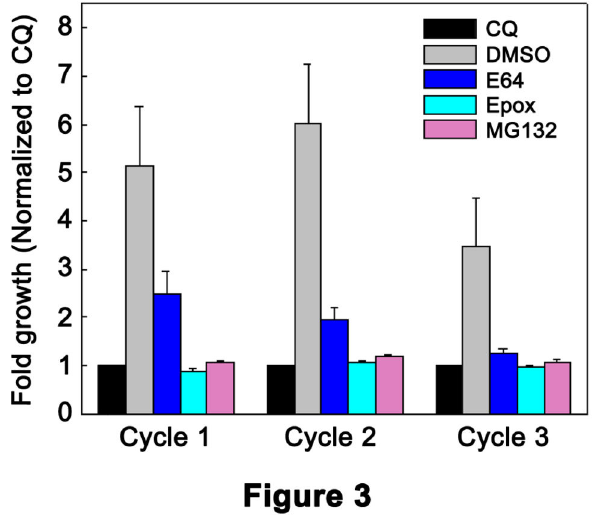
Table 2. Stage-specific effects of inhibitors.